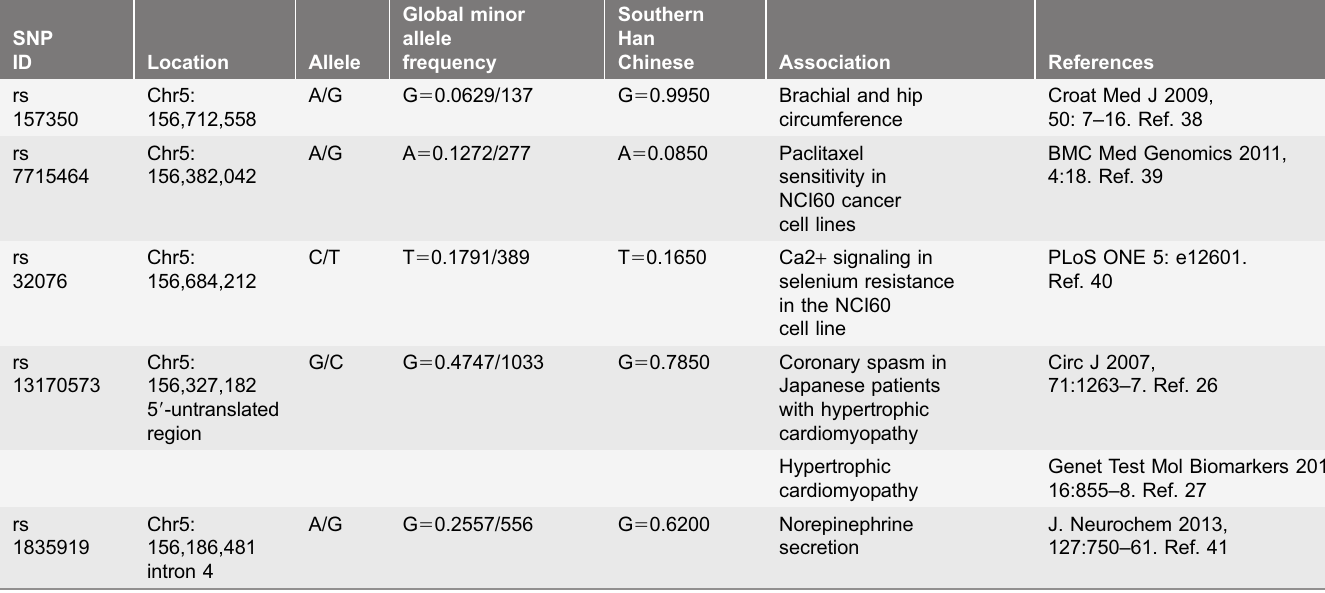
Table 1. Candidate SNPs in the SGCD gene. SNP